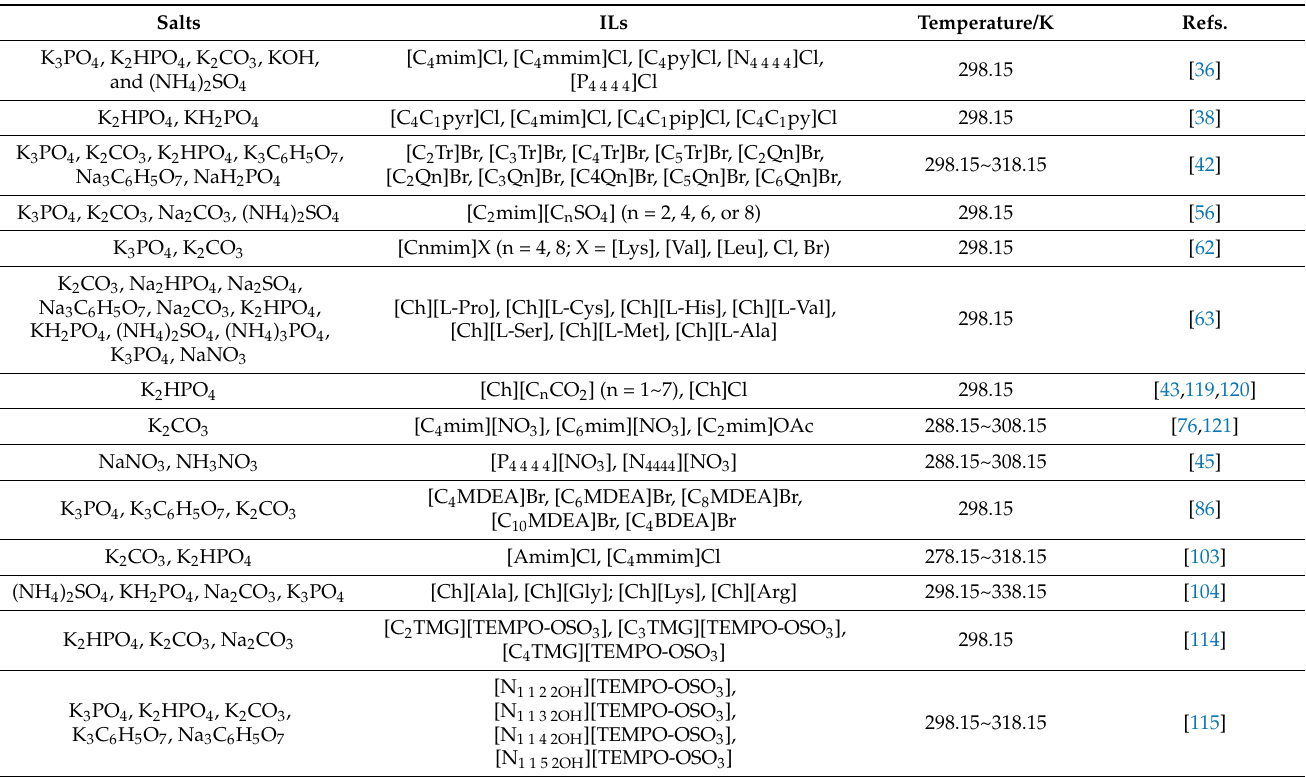
Table 1. Some salts commonly used in the IL-based